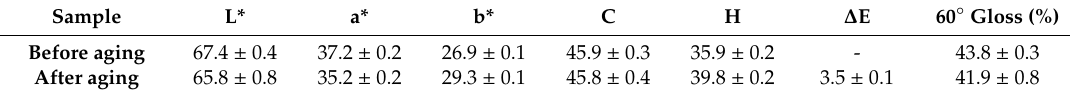
Table 8. Colour difference and gloss change after UV Table 8. Colour di ff erence and gloss change after UV resistance.